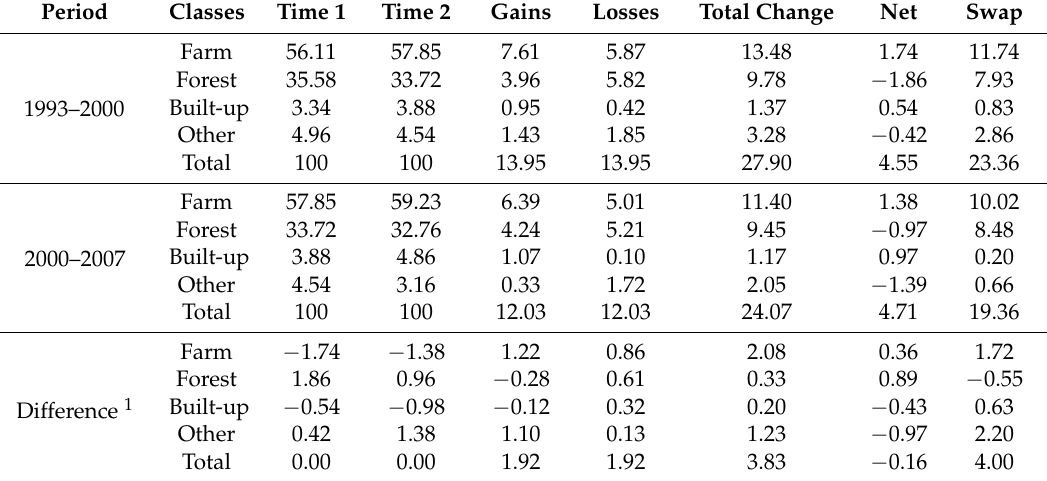
Table 4. Percentages of gains, losses, net changes, and swaps of different land uses before and after the Natural Forest Protection Program (NFPP) was